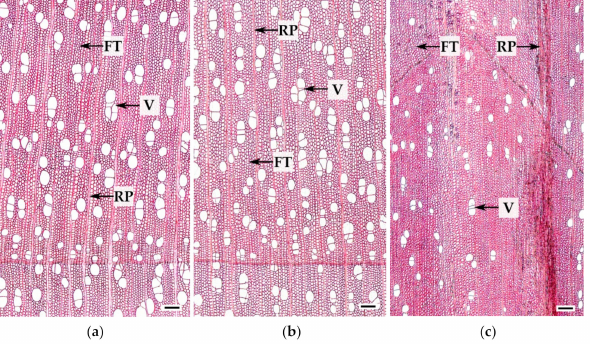
Figure 3. Cross-sections of mature current year xylem of B. pendula var. pendula ( a ), non-figured ( b ), and figured ( c ) B. pendula var. carelica trees. V—vessels, FT—fibrous tracheids, RP—radial parenchyma cells. Scale bar: 200 µ